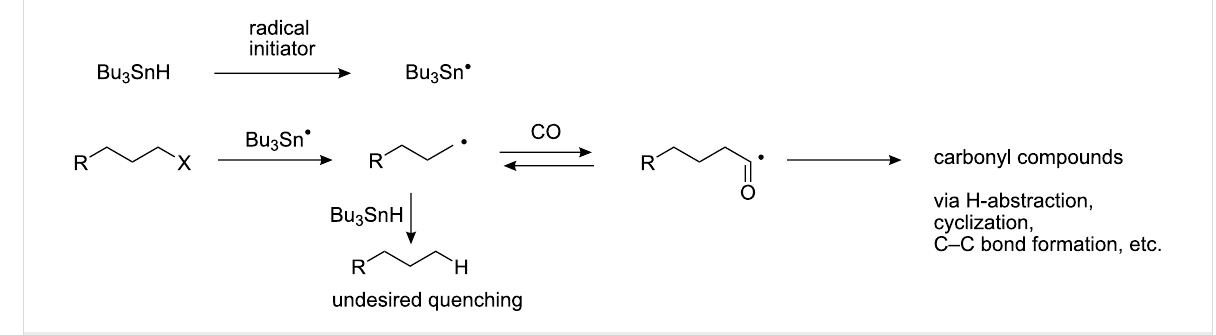
tions, for which we typically used stainless-steel autoclaves as the reactor in batch